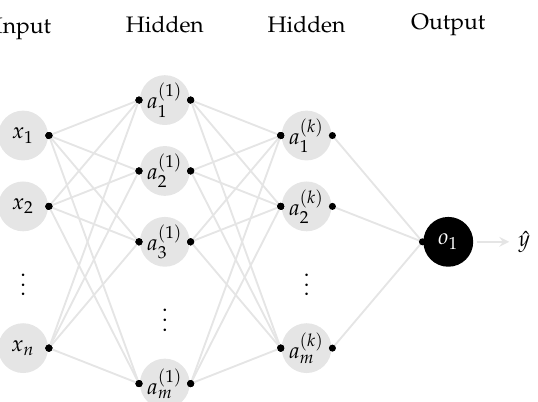
Figure A2. Multi-layer feedforward neural network with one output and n